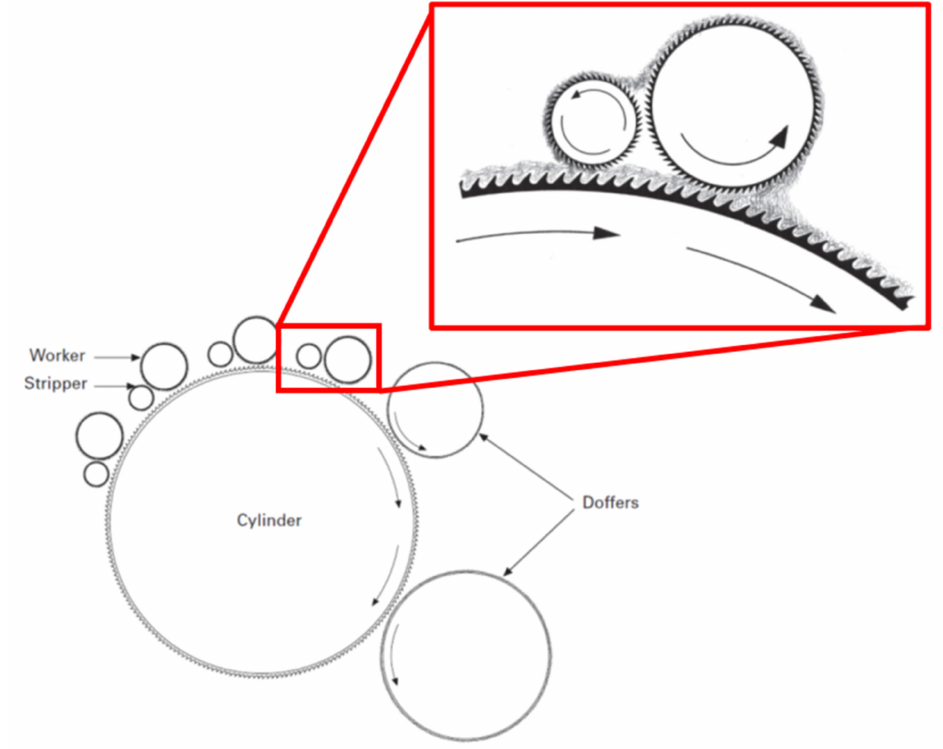
Figure 2. Illustration of carding process and worker-stripper action. Reprinted with permission from [21]. Copyright 2007